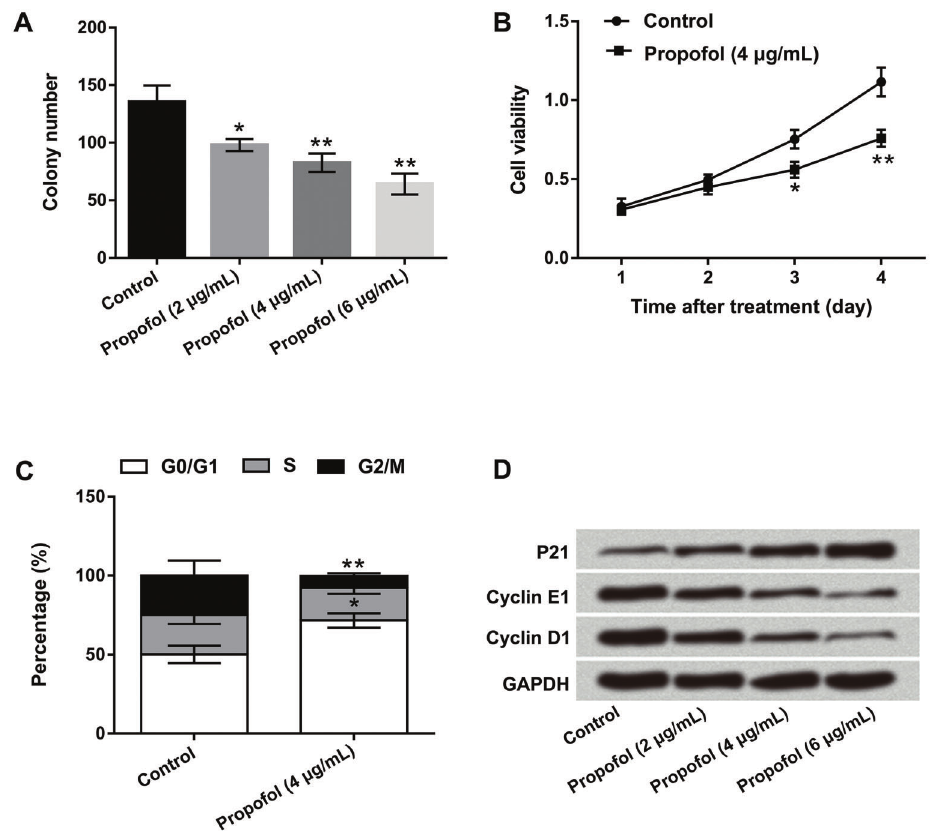
Figure 1. Propofol inhibited cell proliferation in Ishikawa cells. Human EC Ishikawa cell line was exposed to different concentrations of propofol (2, 4, and 6 m g/mL). After treatment for 24 h ( A ) the colony number ( B ) cell viability ( C ) cell cycle and ( D ) the protein levels of cell cycle-related factors (P21, Cyclin E1 and Cyclin D1) were detected by colony formation, MTT, fl ow cytometry, and western blot assays. EC: endometrial cancer; MTT: 3-(4,5-dimethylthiazol-2-yl)-2 5-diphenyl-2Htetrazolium bromide. Data are reported as means ± SD. *P o 0.05; **P o 0.01, compared to control